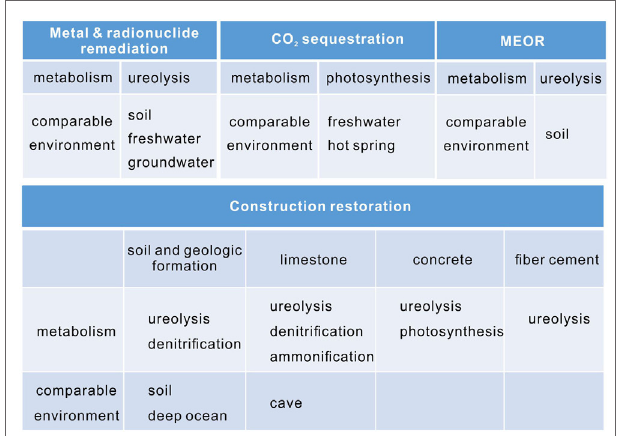
FiGURe 5 | The application areas of microbial carbonate precipitation, their main metabolisms and comparable